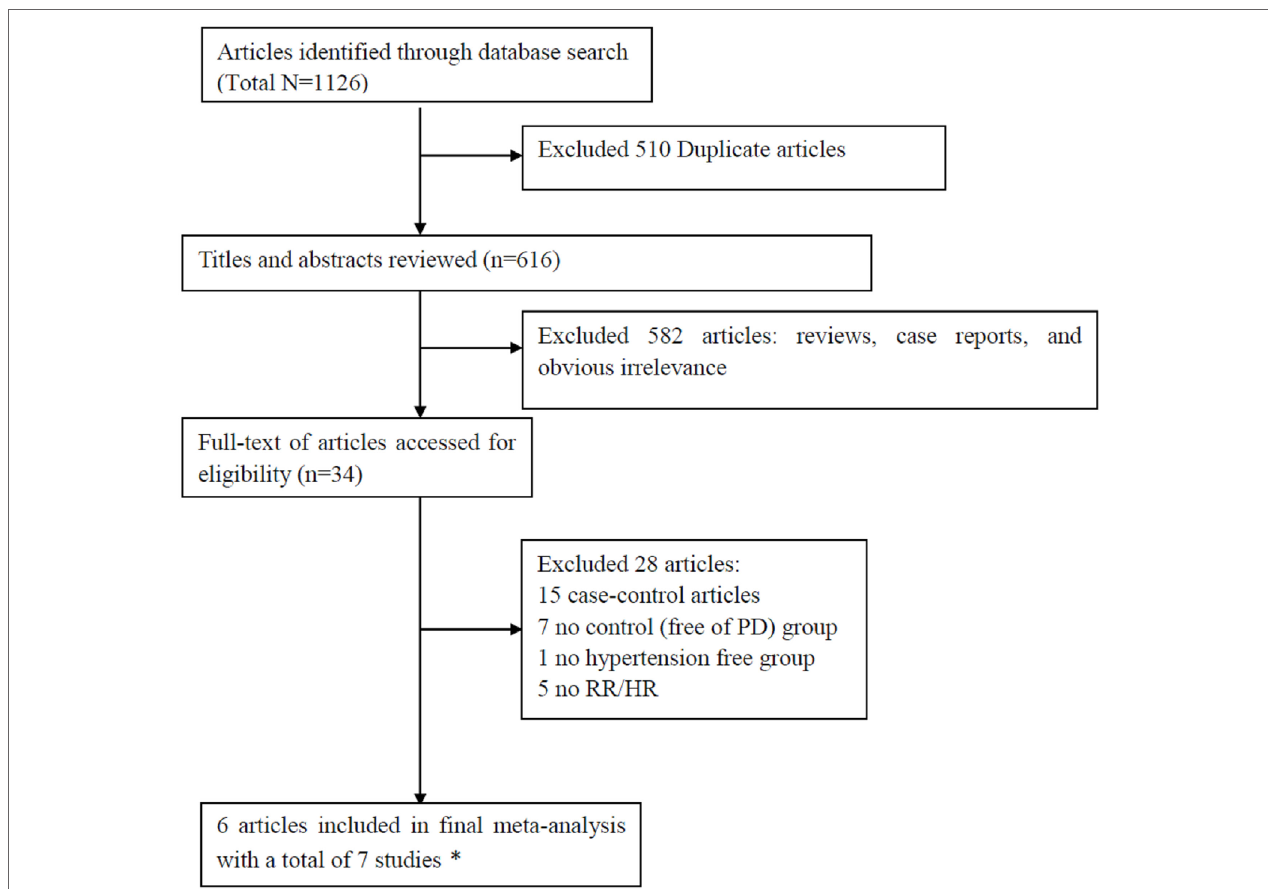
FigURe 1 | Preferred Reporting Items for Systematic Reviews and Meta-analyses flowchart of the literature